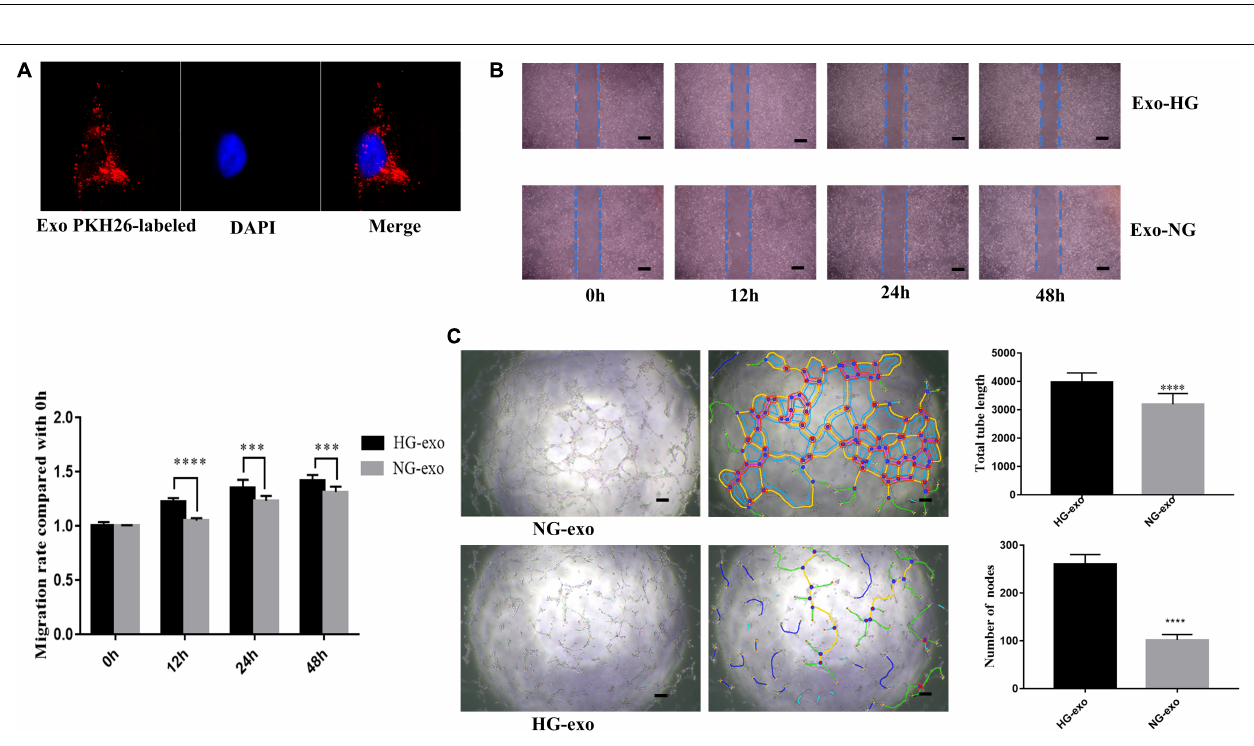
FIGURE 6 | Function of exosomes derived from high-glucose (HG)-induced human retinal vascular endothelial cells (HRVECs) on angiogenesis in vitro . (A) Endothelial cells phagocytosed exosomes labeled by PKH26. (B,C) Exosomes derived from HG-induced HRVECs can enhance the migration (B) and tube formation ability (C) of endothelial cells (ECs) in comparison to negative control (NG) exosomes. Representative images of wound healing and tube formation are shown along with quantitative data ( n = 3). Scale bar , 100 µ m. *** P < 0.0002, **** P < 0.0001.